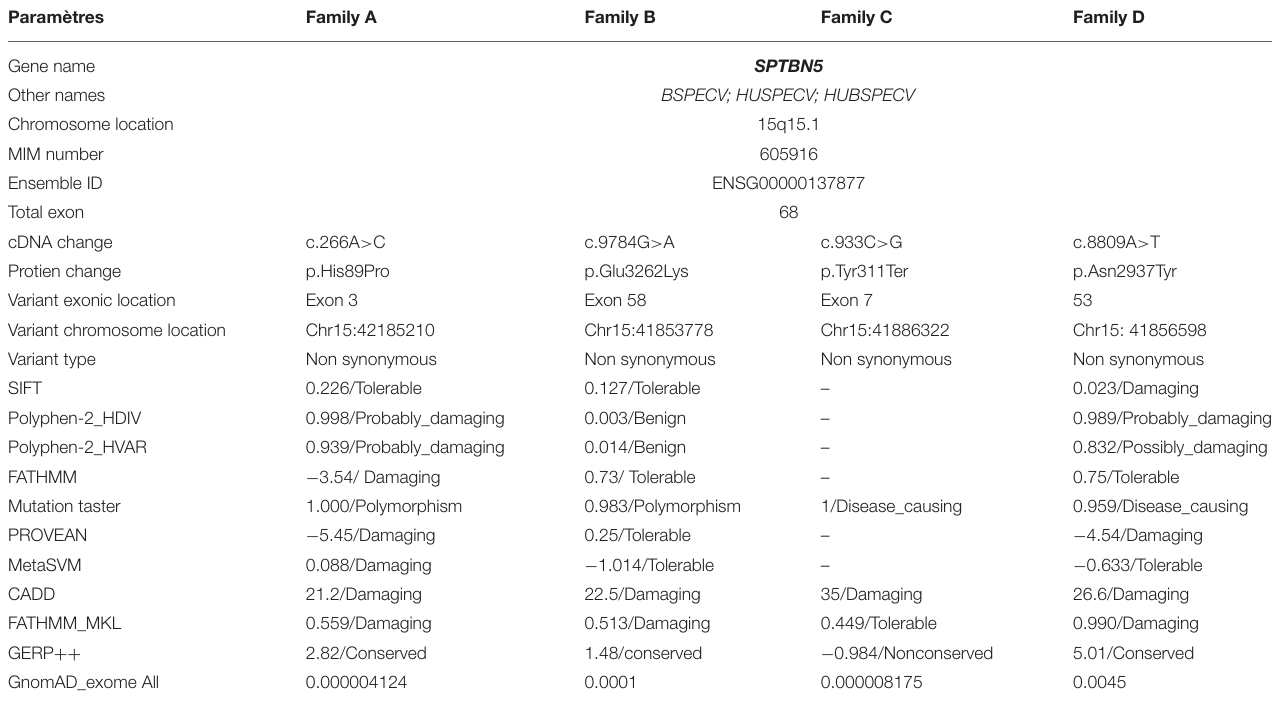
TABLE 2 | In silico prediction analysis of SPTBN5 variants in the present families.